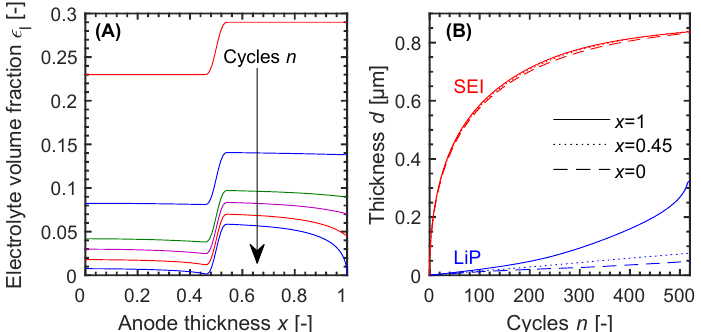
Figure 6. Results for the cell with graded initial anode porosity. ( A ) Electrolyte volume fraction across the thickness of the anode after n = 0, 100, 230, 300, 400 and 520 cycles. ( B ) Equivalent thickness of the surface layer at the current collector ( x = 0, dashed), in the middle of the electrode ( x = 0.45, dotted) and the separator side ( x = 1, solid). SEI formation reduces the porosity, which limits the ion transport into the rear part of the anode, until lithium plating is accelerating the pore clogging.